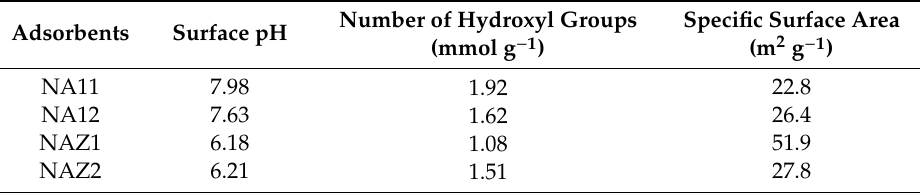
Table 1. Characteristics of adsorbents.